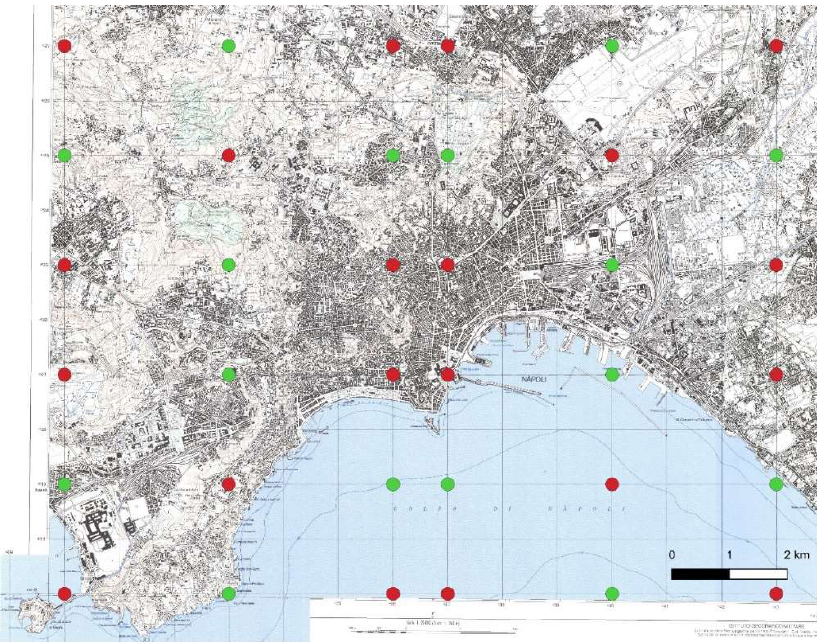
Figure 10. The GCPs (red dots) and CPs (green dots) chosen for georeferencing the topographic map.